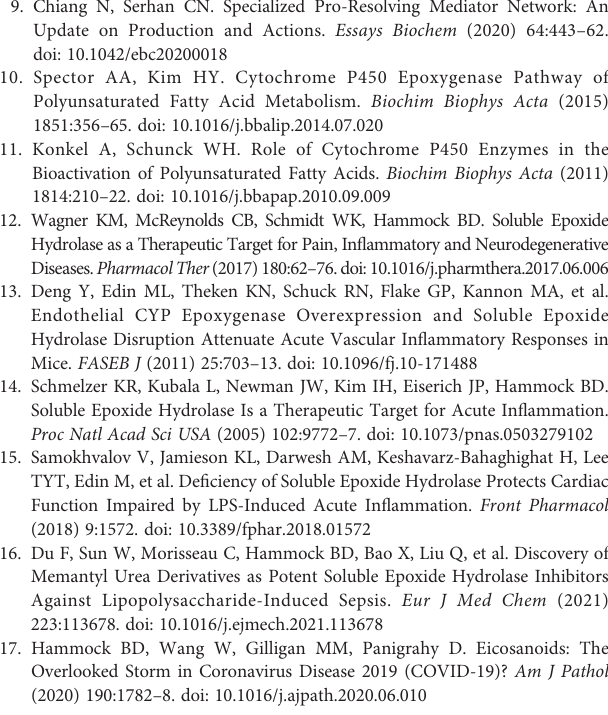
Supplementary Figure 1 | (A) Kaplan-Meier survival curve by gender in the prevention model. The p-value at 72 hours is shown. (B) Treatment protocol (C) Kaplan – Meier survival curve in the treatment model. (D) Kaplan-Meier survival curve by gender in the treatment model. The p-value at 48 and 72 hours is shown. Supplementary Figure 2 | (A) The heart, right kidney and colon tissue from mice subjected to the prevention protocol at 8 hours after LPS administration. (B) The total in fl ammatory score and categorization of the score of the livers in mice subjected to the prevention protocol 8 hours after LPS administration. All bars on the images are 50 m m. Supplementary Figure 3 | | RNA expression of proin fl ammatory cytokines in THP-1 cells in in fl ammation model. The cells were harvested 6, 12, 24 hours after LPS administration. P-values **: < 0.0001, *: 0.0001 to 0.05. All experiments were triplicated. Supplementary Figure 4 | RNA expression of anti-in fl ammatory cytokines in THP-1 cells in in fl ammation model. The cells were harvested 6, 12, 24 hours after LPS administration. P-values **: < 0.0001, *: 0.0001 to 0.05. All experiments were triplicated. Supplementary Figure 5 | (A) The histogram of in fl ammation model THP-1 cells polarized to M1 macrophages. (B) The histogram of U937 cells polarized to M2 macrophages. Supplementary Figure 6 | (A, B) The assessment of phagocytosis (A) and lysosomal pH (B) of THP-1 cells, the in fl ammation model. The MFI ratio of FITC to a Phagocytosis Assay Kit IgG-FITC (A, left panel) and the positive percentage of phagocytosis (A, right panel). The MFI ratio of FITC to pHrodo Green dextran (B, left panel) and the positive percentage of lysosomal pH ( B , right panel). (C) The histogram of phagocytosis and lysosomal pH in the in fl ammation model THP-1 cells. **: < 0.0001, *: 0.0001 to 0.05. Supplementary Figure 7 | The histogram of Dj and mtROS levels in the in fl ammation model THP-1